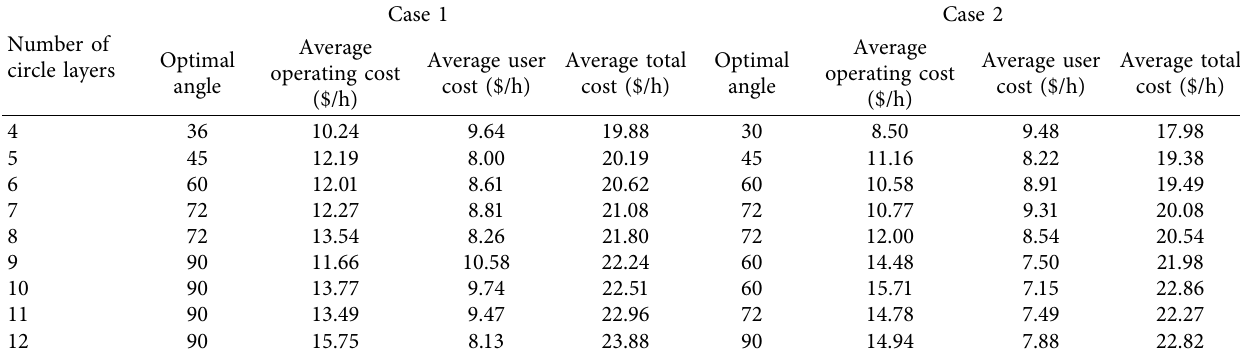
Table 5: Joint optimal solution for circle layers variations.